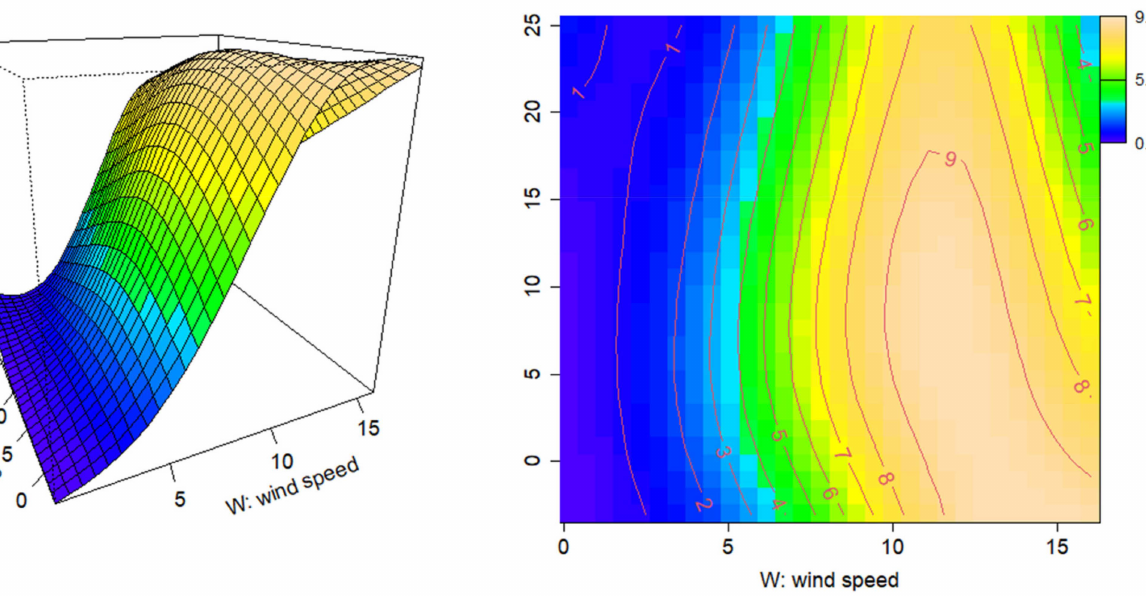
Figure 4. Estimated trends of non-parametric derivatives (left: perspective, right: